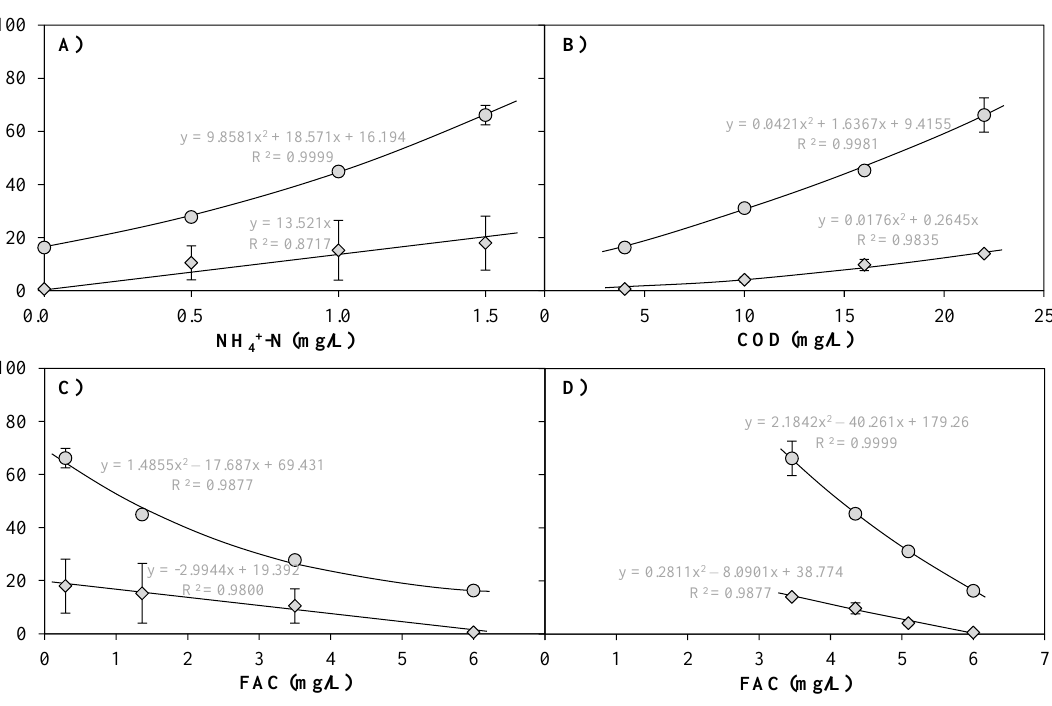
Figure 8. Carbamazepine ( ) and diclofenac ( ) after treatment of tap water spiked with NH 4 Cl (Exp. A, <5 mg/L COD) and dilutions of WWTE with tap water (Exp. B, <0.1 mg/L NH 4+ -N) by means of an AOP pilot plant at 1 m 3 /h, 6.9 mg/L dosed Cl 2 , 0.4 kW UV lamp power (0.4 kWh/m 3 electrical energy consumption) and subsequent quenching with around 3.2 mg/L H 2 O 2 as functions of NH 4+ -N ( A ); COD ( B ) and FAC concentration as detected in the UV chamber influent ( C : Exp. A; D : Exp. B). For E EO values, see Table S6.